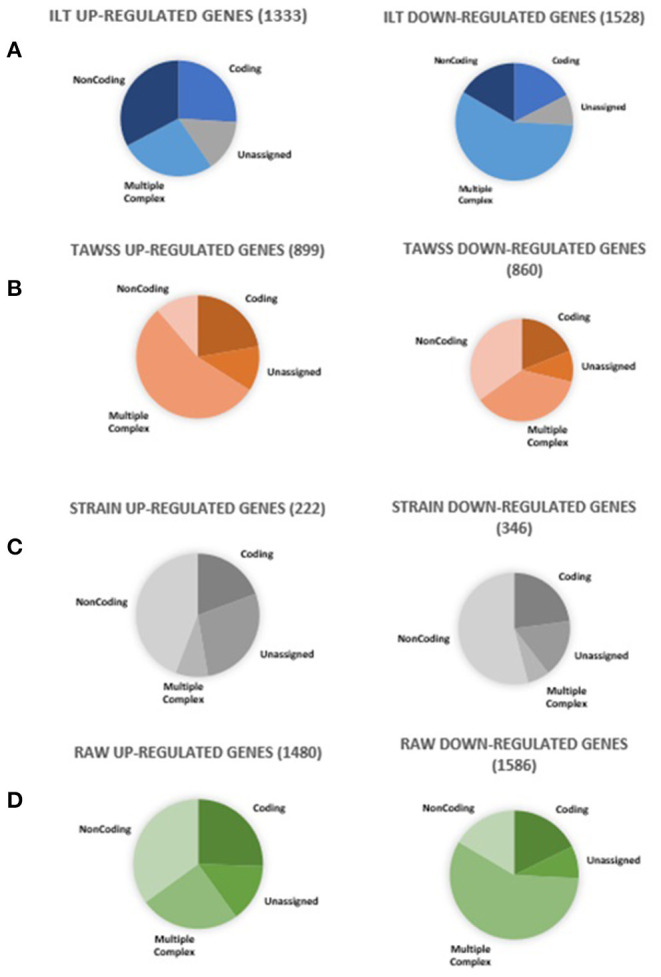
Summary of genes differentially expressed in RAW and all its constitutive metrics. Ten aortic samples were analyzed, with one microarray being performed on each tissue sample.